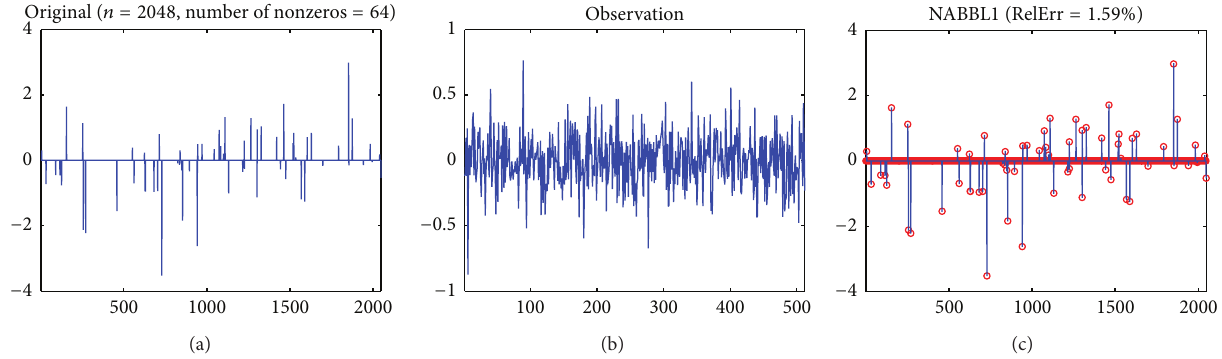
Figure 1: (a) Original signal with length of 2048 and 64 nonzero elements. (b) Noisy measurement with length of 512. (c) Recovered signal by NABBL1 (red circle) versus original signal (blue